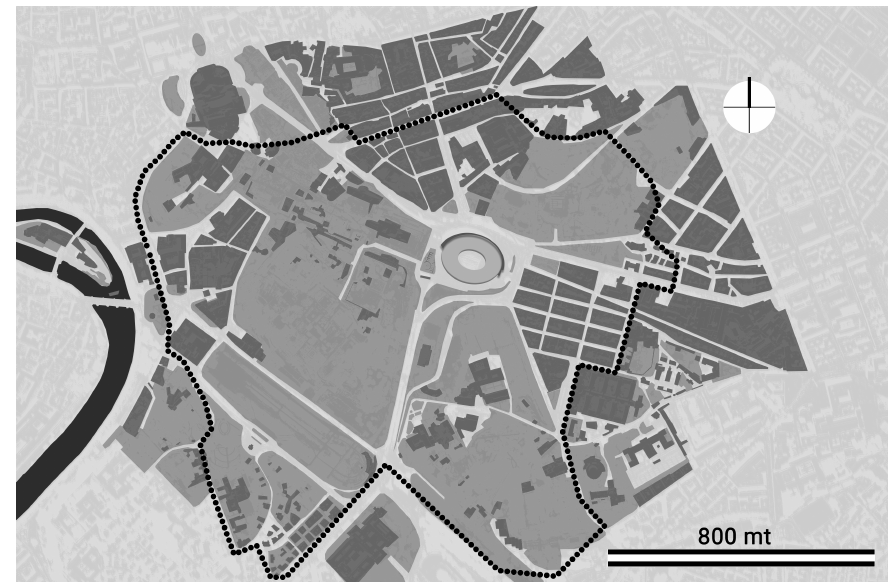
Figure 5. The central archaeological area of Rome (Italy), details of the Colosseum area.